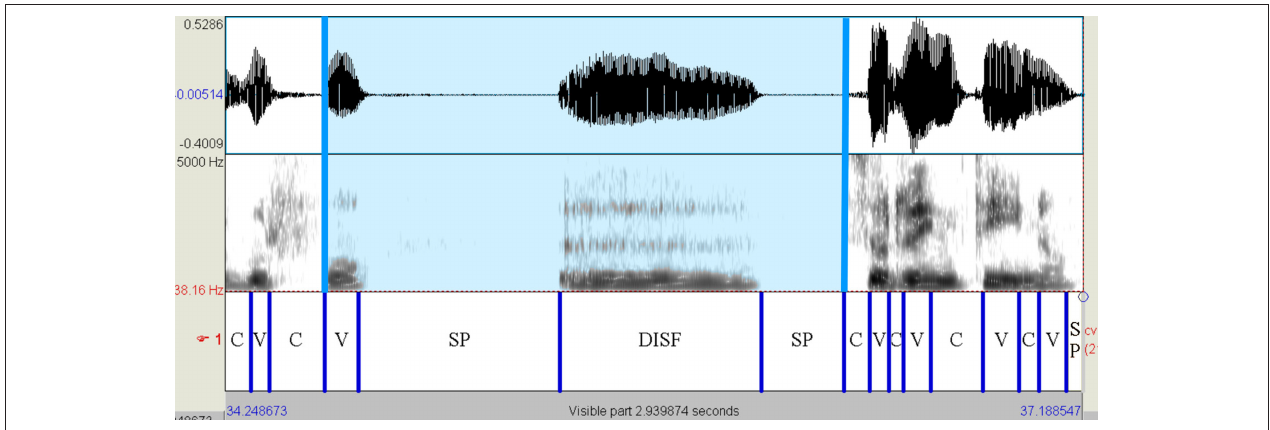
FIGURE 3 | Spectrogram of the utterance “ golfo < sp > [e:] < sp > sorrentino ” (HC female voice—monolog). The presence of disfluencies, a vocalization in this case, testifies to the spontaneous nature of the utterance. The blue-colored interval, including prepausal vowel, disfluency, and silent pauses, has not been considered in determining the VtoV value. On the contrary, the prepausal vowel was taken into account in calculating the %V. HC, healthy control; C, consonantal interval; V, vocalic interval; SP, silent pause; DISF,